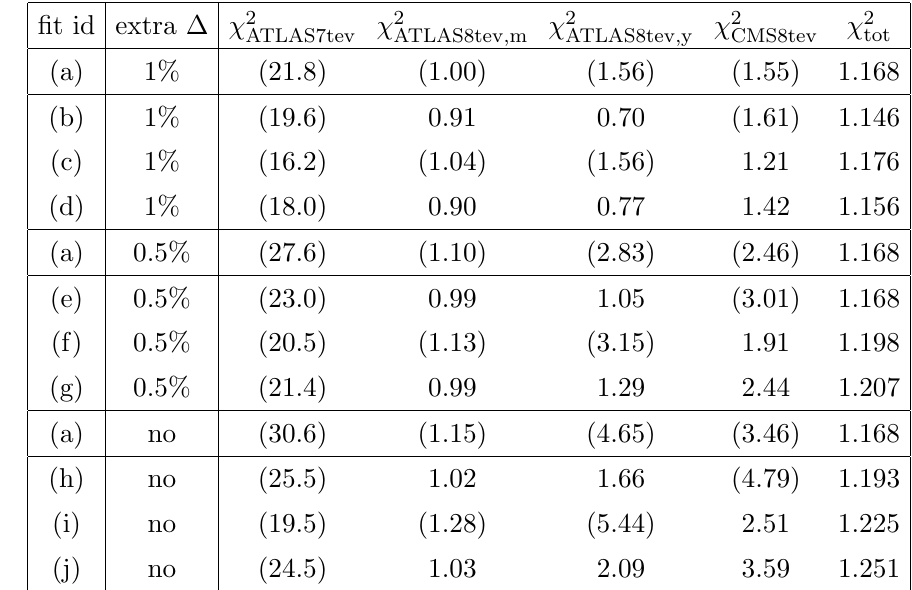
Table 6 . Fully correlated (cid:31) 2 for the (cid:12)ts described in table 5. The numbers in brackets cor- d : o : f : respond to the (cid:31) 2 for experiments which are not (cid:12)tted. In particular the ATLAS 7 TeV data are not (cid:12)tted in any of these (cid:12)ts. The total (cid:31) 2 is computed over all baseline HERA data the included p Z T